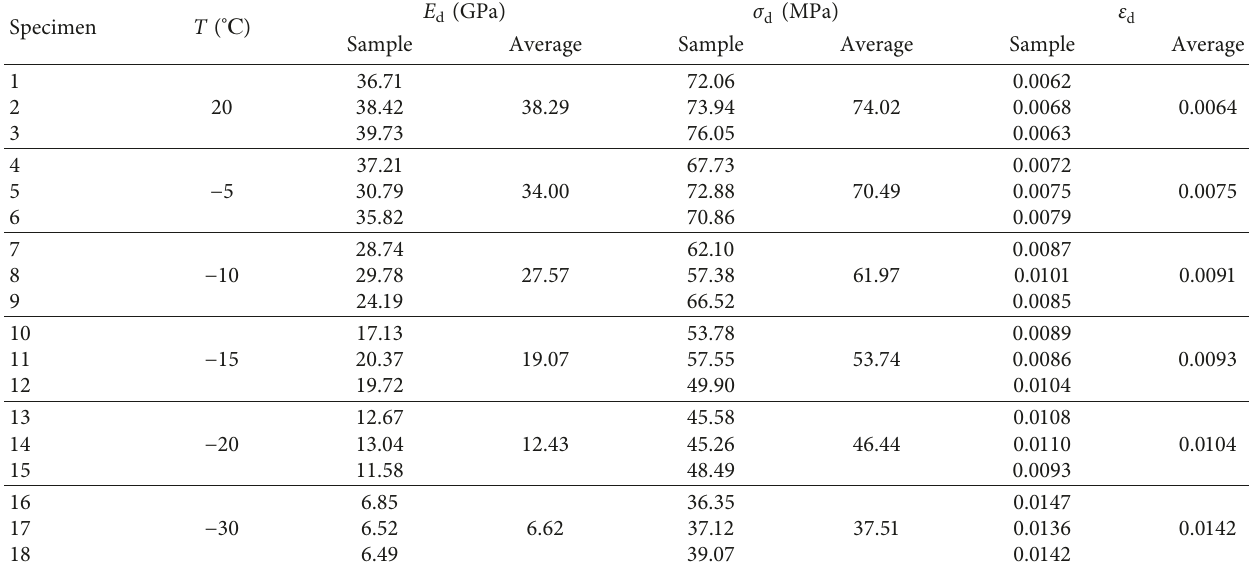
Table 3: Dynamic elastic modulus ( E d ), peak strength ( σ d ), and peak strain ( ε d ) under different freezing temperatures ( σ d is the peak stress of dynamic stress-strain curve; ε d is the strain corresponding to the peak stress; and E d is the slope of the stress-strain curve in elastic stage).